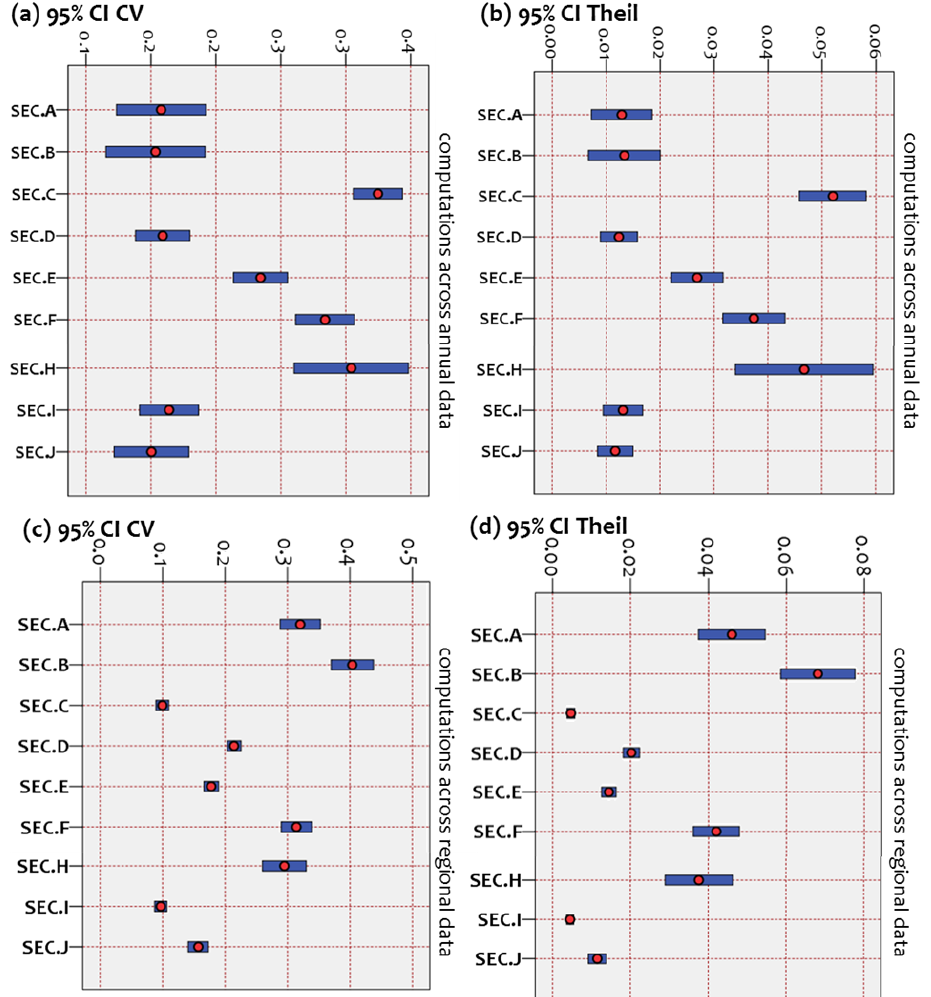
Figure 6. Error bars of 95% CI for the mean value of: ( a ) the coefficient of variation (CV) and ( b ) the Theil index, per sector, where the measures’ computations applied across annual data of GVA (pLU). Error bars of 95% CI for the mean value of ( c ) the CV and ( d ) the Theil index, per sector, where the measures’ computations applied across regional data of GVA (pLU). GVA prices measured in EUR/LU (constant prices on 2008